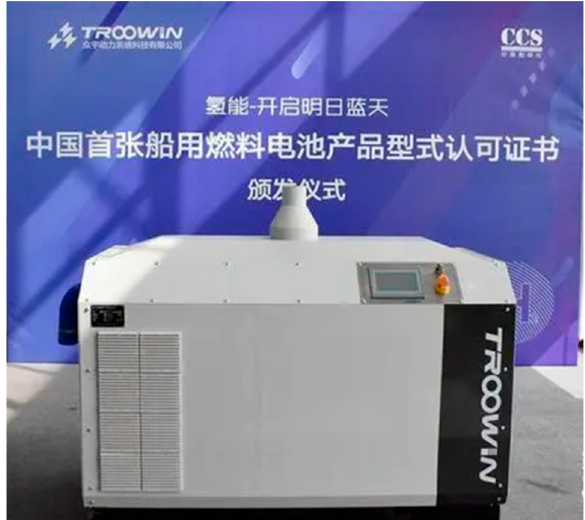
Figure 30. Type TWZFCSZ marine fuel cell system [154]. Table 3. The detailed parameters of the TWZFCSZ marine fuel cell system [154].